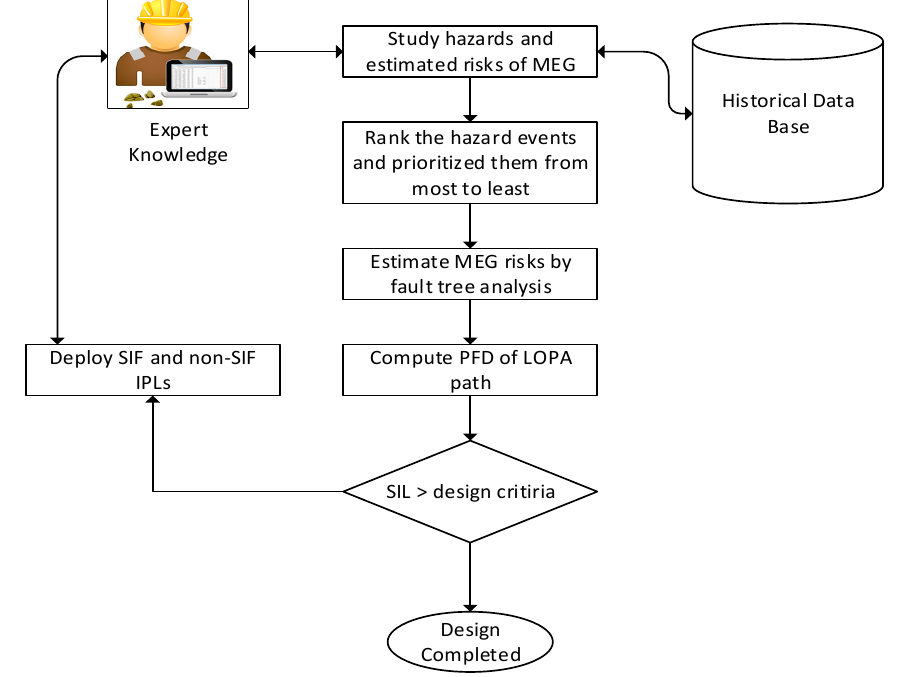
Figure 2. The research methodology.